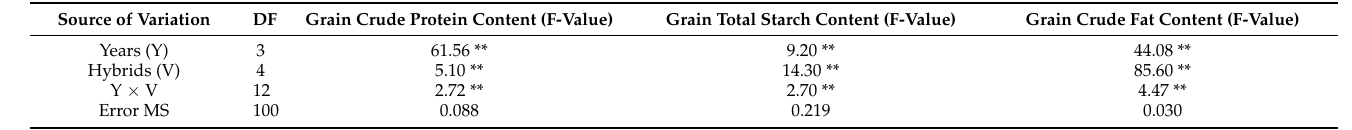
Table 3. ANOVA results for grain nutritional quality measured between the growing year and